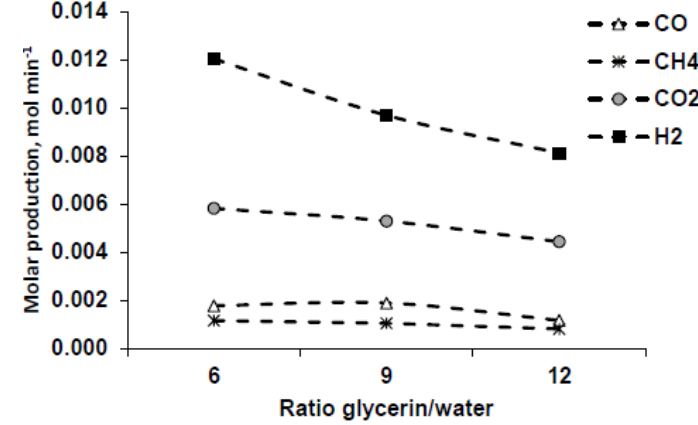
Figure 5. Evolution of gases with water/glycerin ratio. Temperature: 900 °C. Flow rate: 3 mL ∙ min − 1 . Table 4. Characteristic parameters from glycerin steam gasification. Effect of water/glycerin ratio. Flow rate 3 mL ∙ min − 1 . Temperature 900 °C.